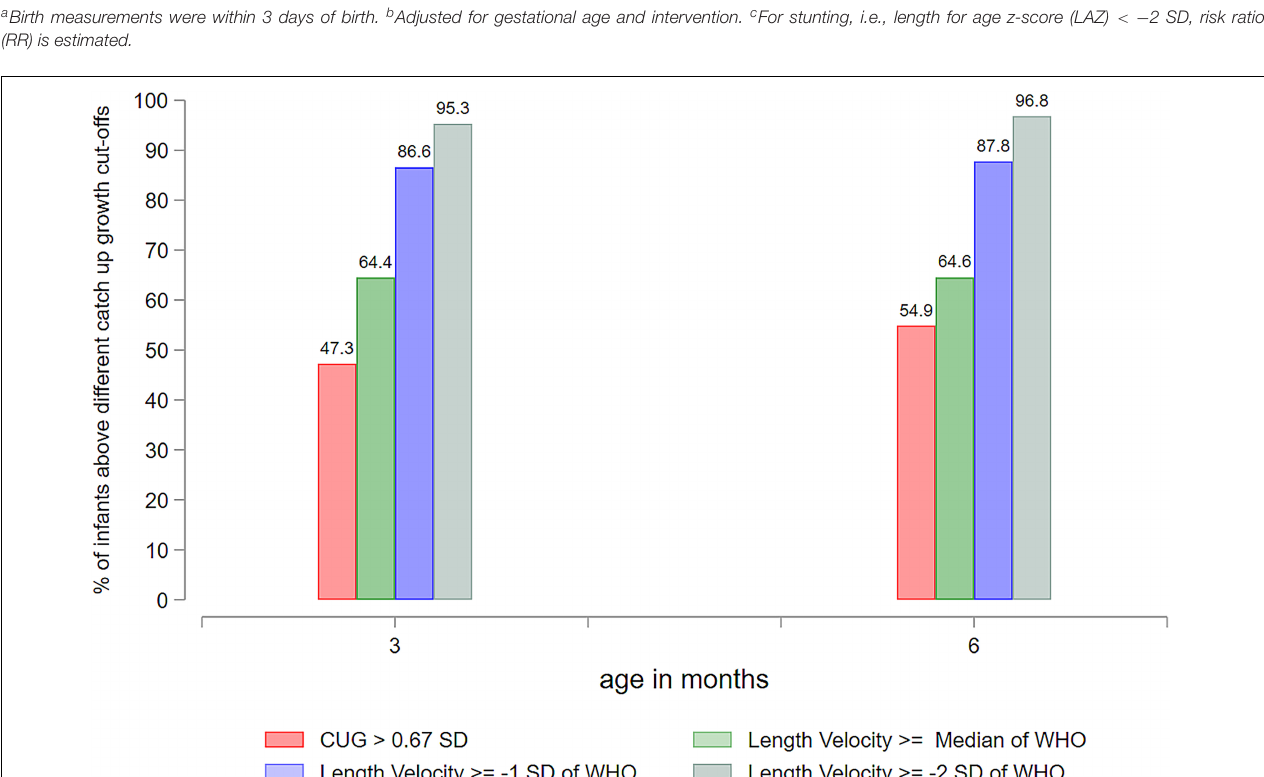
the least poor ( RR 0.74, 95% CI : 0.64–0.86; Table 2 ) or less poor families ( RR 0.86, 95% CI : 0.76–0.97) compared with the poorest families. Infants born at hospitals had a lower risk of poor catch-up growth against those born at home ( RR